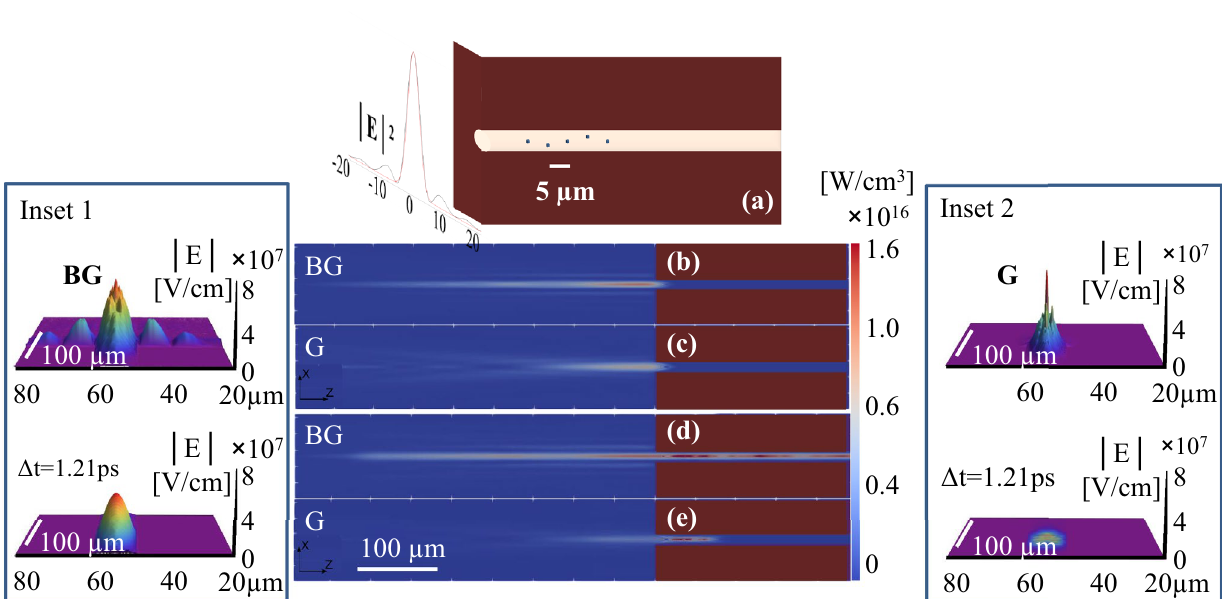
Figure 8. Beam traces (accumulated power density of the traveling wave) during the interaction with the metal target for two particular moments in the simulation. ( a ) The schematic description of the modeling geometry. ( b ) Energy density ρ P for the Bessel beam before the beams arrive the focus on the metal surface. ( c ) ρ P for the Gauss beam before the beams arrive at the focus. ( d ) ρ P for the Bessel beam before the end of the channel. ( e ) ρ P for the Gauss beam before the end of the channel. The Bessel beam penetrates far deeper into the channel replicating successively in space the beam projection from the entrance. The insets show the instantaneous electric field (modulus) distributions of the Bessel (Inset 1) and the Gauss (Inset 2) wavepackets at the entrance of the crater and in the crater end (sectional view), with a time delay difference of 1.21 ps. One notes the field enhancement at the entrance and the field reshaping within the structure, as well as the efficient damping of the Gauss